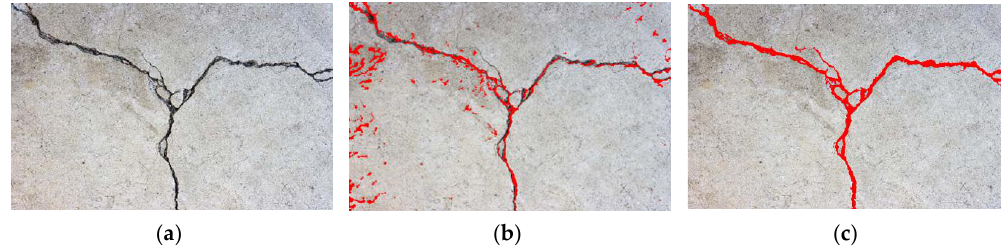
Figure 15. The comparison of the proposed method with Talab’s method for a clear crack case. ( a ) Clear crack case; ( b ) Talab’s method; ( c ) Proposed method.